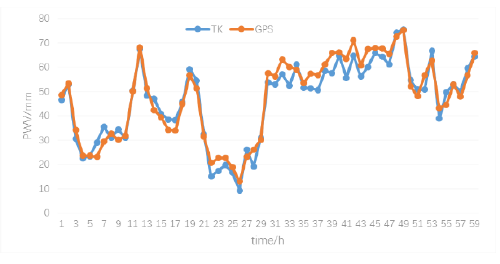
Figure 6. Wuhan sounding station and GPS inversion data comparison